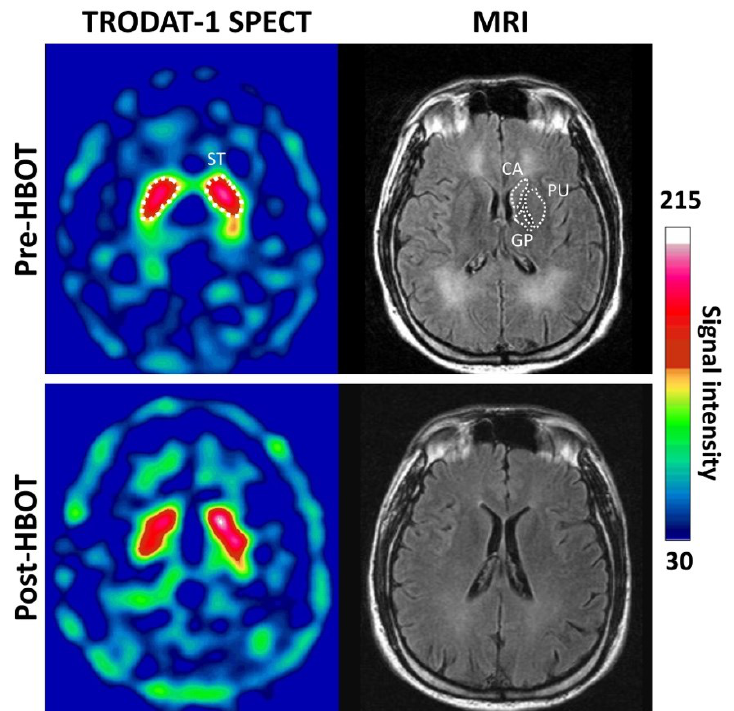
Figure 1. Representative transverse 99mTc-TRODAT-1 DAT SPECT and MR images. The striatal region of a 35-year-old male subject of 99mTc-TRODAT-1 and MR images obtained before and 3 months after HBOT. Regions of interest included the head of the caudate, the putamen and globus pallidus (white dot line) which correspond to 99mTc-TRODAT-1 SPECT. Relative 99mTc-TRODAT-1 DAT uptake in the striatal regions on both sides was low at baseline and slightly increased at 3-month follow-up.